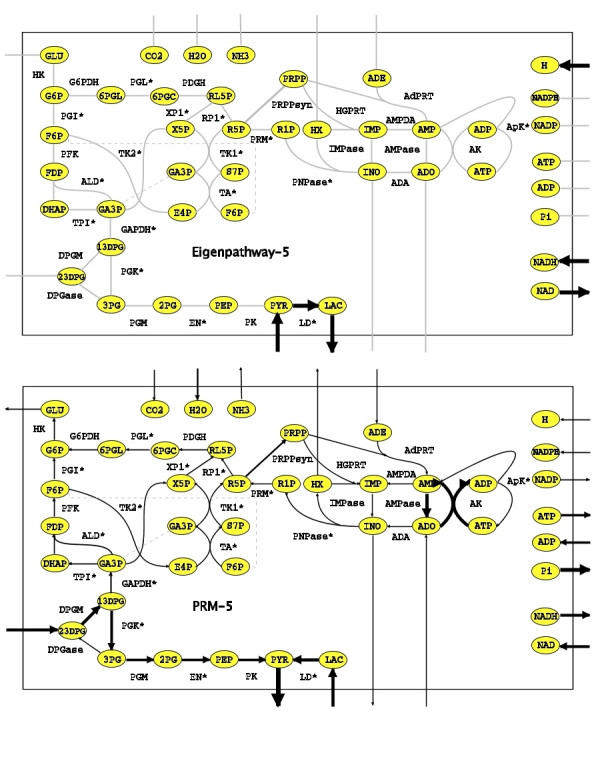
The fifth eigenpathway derived from SVD of the extreme pathways matrix and the fifth PRM derived from SVD of the samples matrix for the hRBC metabolic network. The relative values of the flux values is indicated by the thickness of the arrows between metabolites. The metabolite and reaction definitions are given in Table 1 and Table 2.